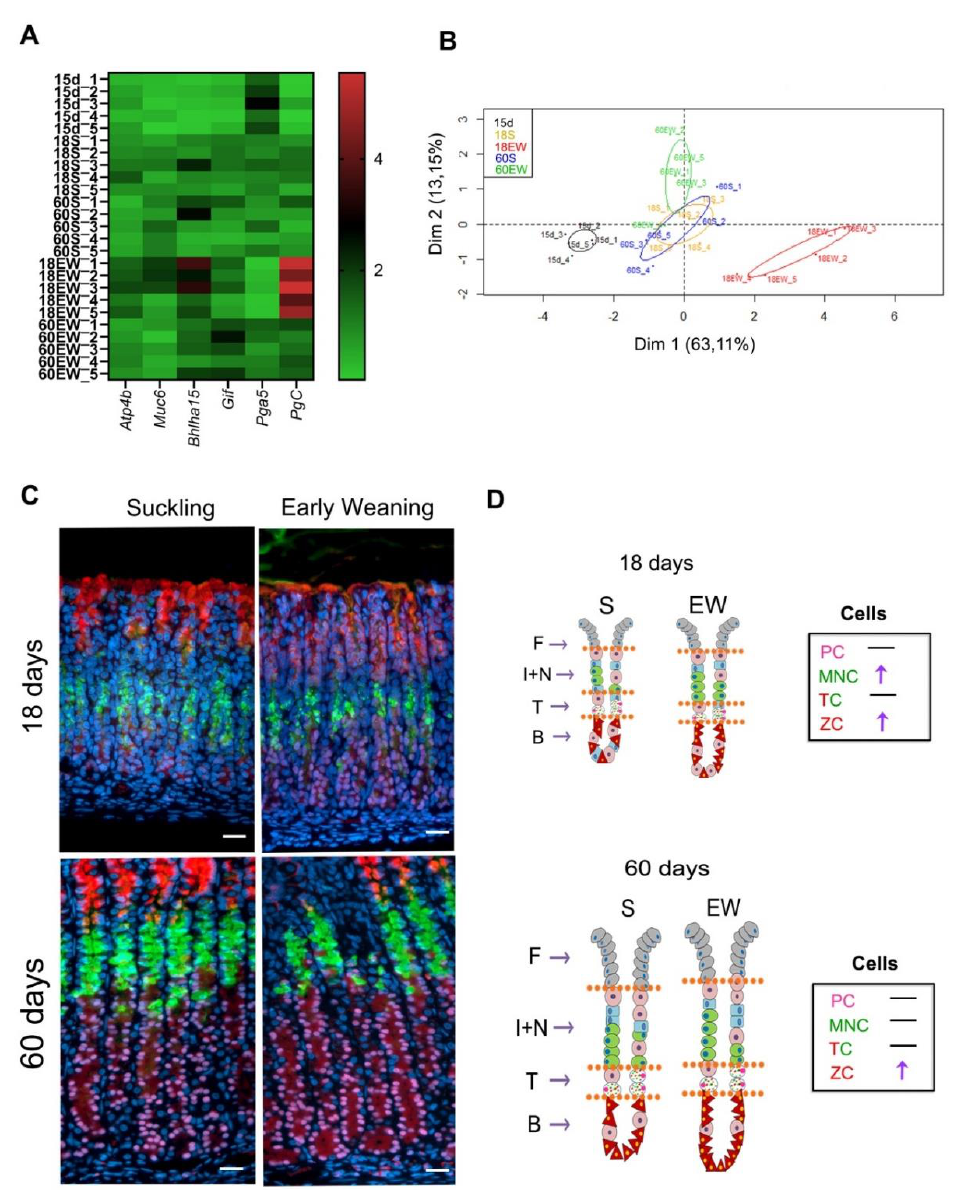
Figure 6. Summary of early weaning effects on the differentiation of gastric cells: transient and permanent responses. ( A ) Heat map of gastric mucosa gene expression data at different ages. Red represents increased gene expression, while green represents reduced gene expression. ( B ) Principal Component Analysis (PCA) of gastric mucosa gene expression data. PCA two-dimensional scatter plot represent the differential gene expression patterns of suckling and early-weaning rats at different ages. Axis: X = Dim1-Principal Component 1 (63.11% variance); Y = Dim2-Principal Component 2 (13.15% variance). ( C ) Representative images from the gastric mucosa of suckling and early- weanling rats at 18, and 60 days. Sections were used for multiple labeling to detect: mucous granules (GSII/FITC) in MNC and TC; Mist1/Cy3 in the nuclei of TC and ZC; GIF/AlexaFluor 633 in serous granules in TC and ZC. Nuclei were counterstained with DAPI. Images were obtained under fluorescence microscope, using separated filters, and they were combined through Zen Software. Acquisition at X 40. Bar = 50 μm. ( D ) Schematic distribution of PC, MNC, TC and ZC in the gastric mucosa (F—foveola; I + N—isthmus and neck; T—transition; B—base). When cellular distribution was compared between S and EW at both ages (Figure 6C,D), we noted that at 18 days, both MNC and ZC populations were altered, and at 60 days, only the number